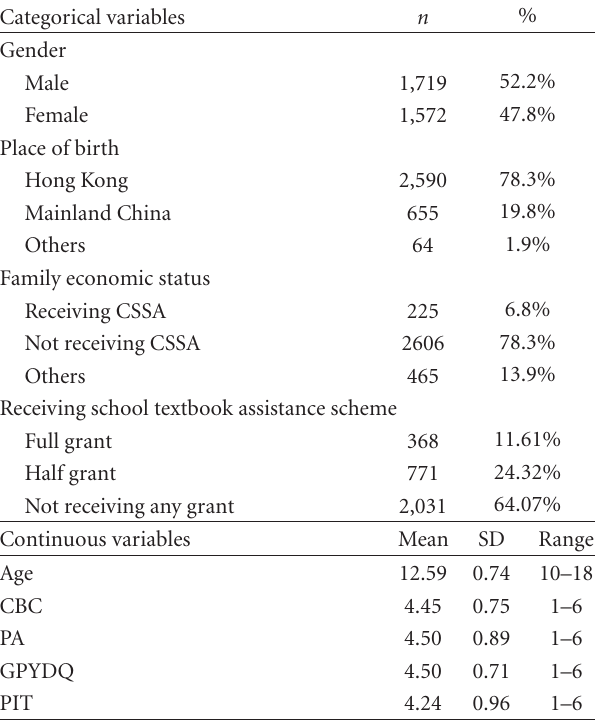
Table 1: Descriptive statistics about